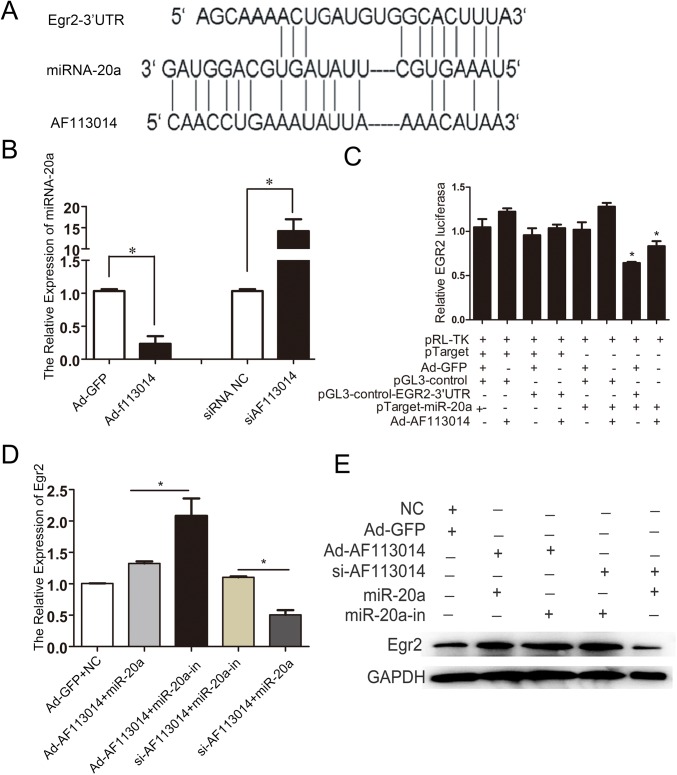
AF113014 up-regulated Egr2 expression by interacting with miR-20a.(A) Software predicted the binding sites between AF113014, miRNA-20a and Egr2-3'UTR. (B) Relative expressions of miRNA-20a in Ad-AF113014 or siAF113014 transfected SMMC7721 cells. U6 RNA was used as control. (C) Luciferase activity assay was performed to determine the relationship between AF113014, miRNA-20a and Egr2 in SMMC7721 cells.* P < 0.05, ** P<0.01. (D) qRT-PCR were performed to analyze the expressions of Egr2 after co-transfected with Ad-AF113014 and miRNA-20a, Ad-AF113014 and miRNA-20a-in, siAF113014 and miRNA-20a, siAF113014 and miRNA-20a-in, respectively. Ad-GFP+NC was used as control. (E) Western blot were performed to analyze the expressions of Egr2 after co-transfected with Ad-AF113014 and miRNA-20a, Ad-AF113014 and miRNA-20a-in, siAF113014 and miRNA-20a, siAF113014 and miRNA-20a-in, respectively. Ad-GFP+NC was used as control.